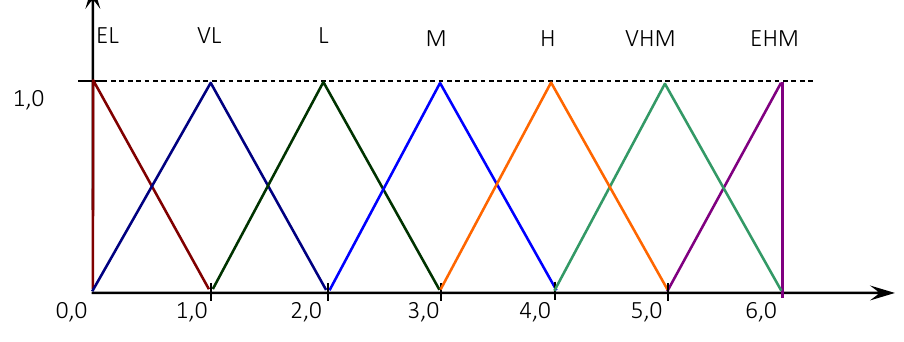
Figure 2. Evaluation terms of membership Table 1. Term set with respective triangular fuzzy